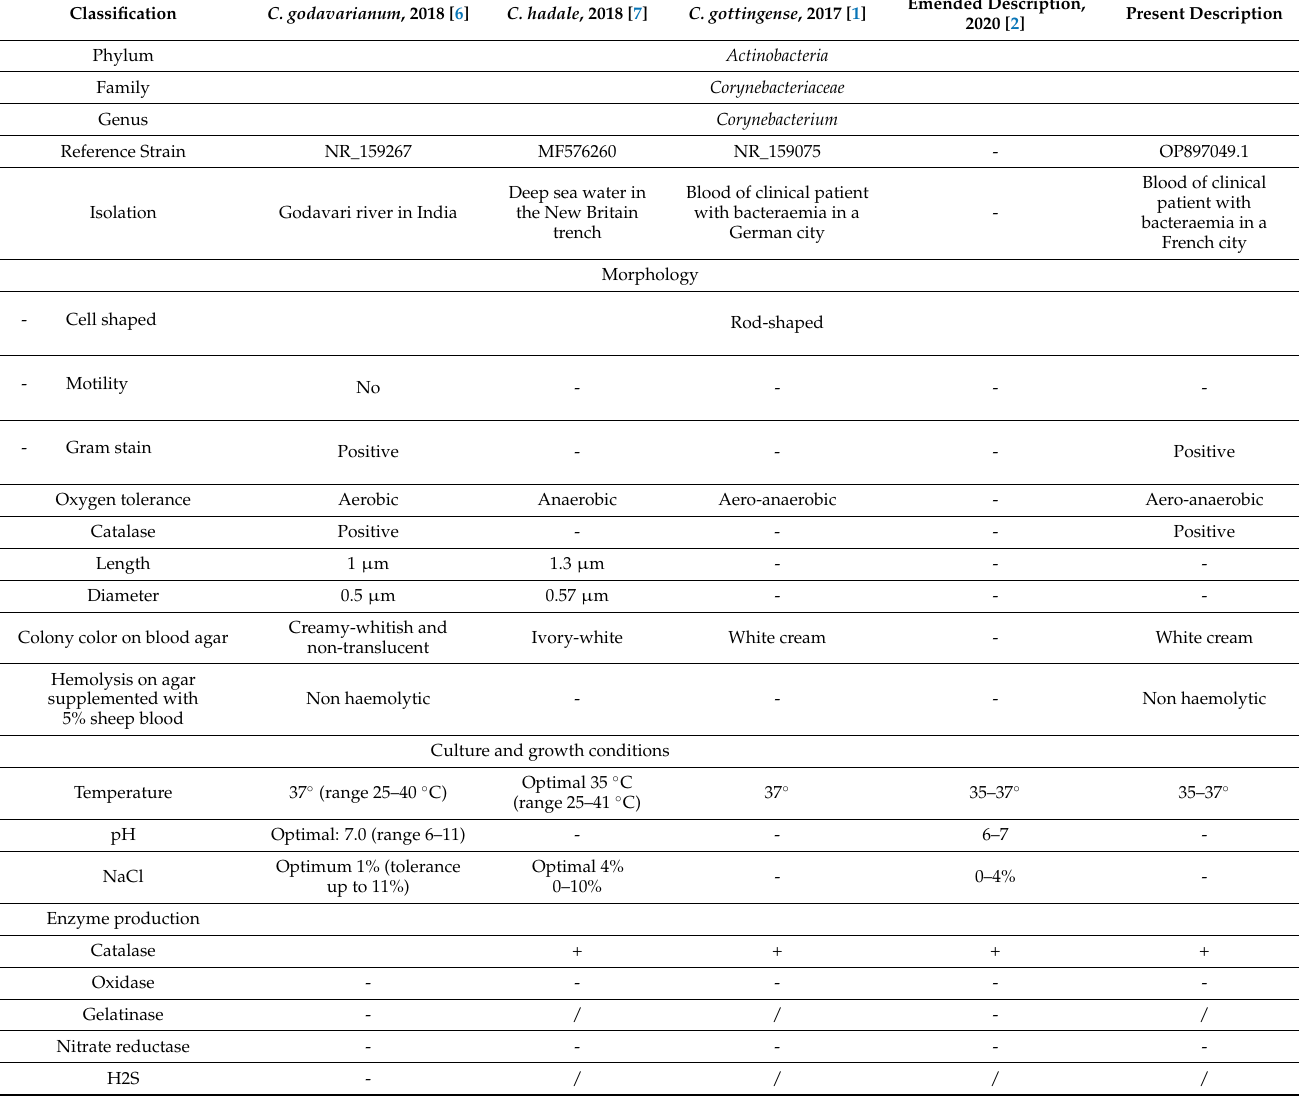
Table 1. Comparison between the different strains of Corynebacterium spp. to an emended description of Corynebacterium gottingense in